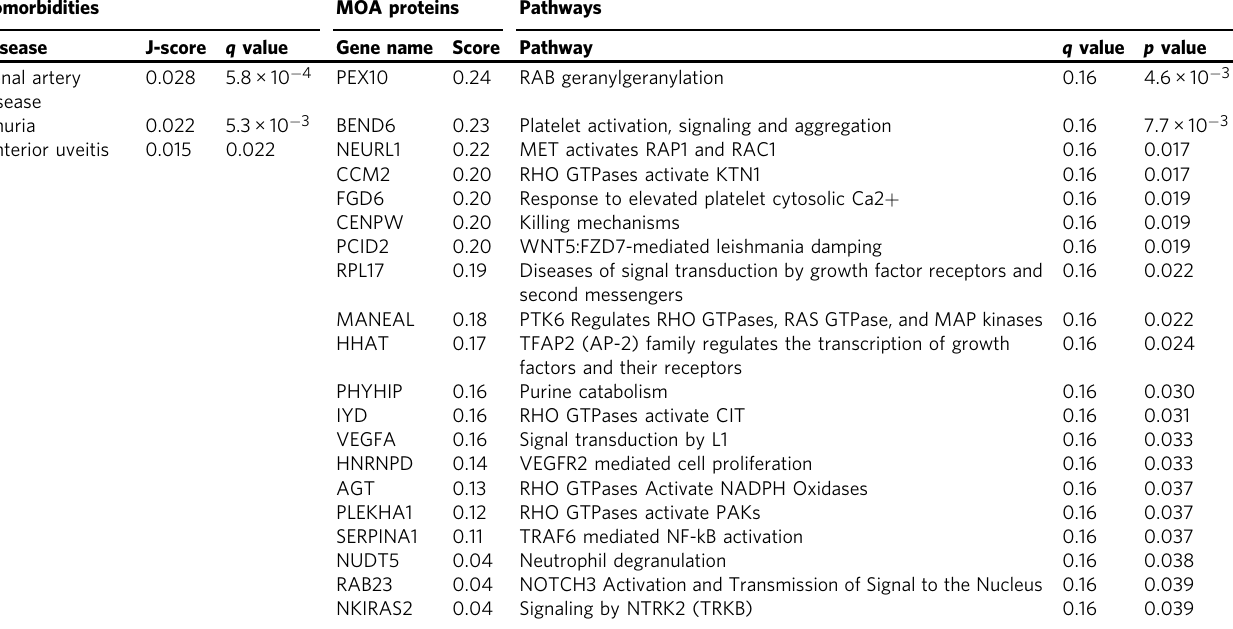
Table 3 Up to top 20 comorbidities, top 20 comorbidity enriched MOA proteins (with respect to input), and top 20 pathways (ranked by p value since q values are the same) associated with the prediction CAD GWAS-driven LeMeDISCO results using the gene set from ref. 30